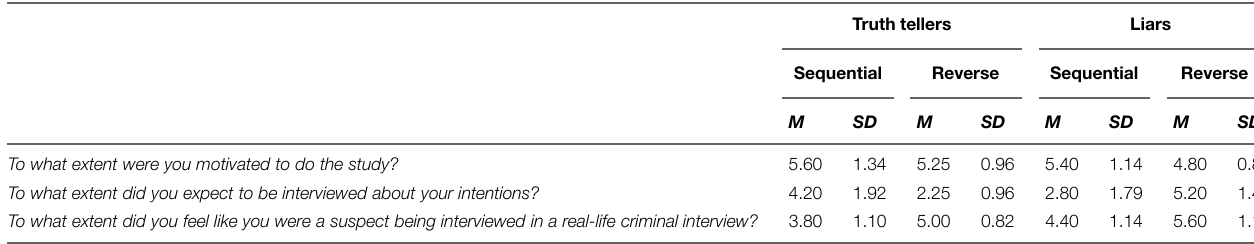
TABLE 1 | Ratings of motivation and realism.